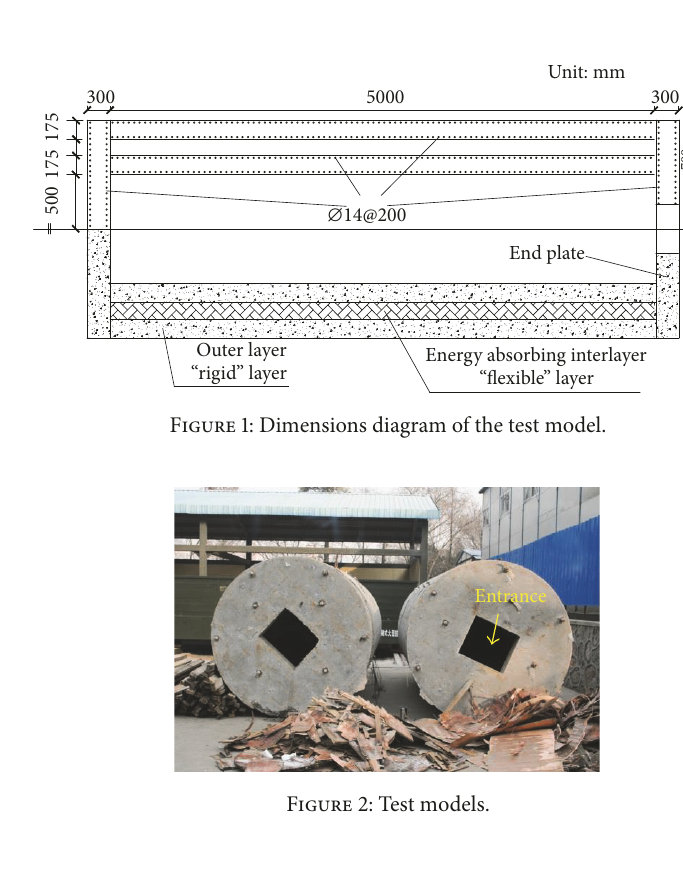
Table 1: Parameters of foam concrete.